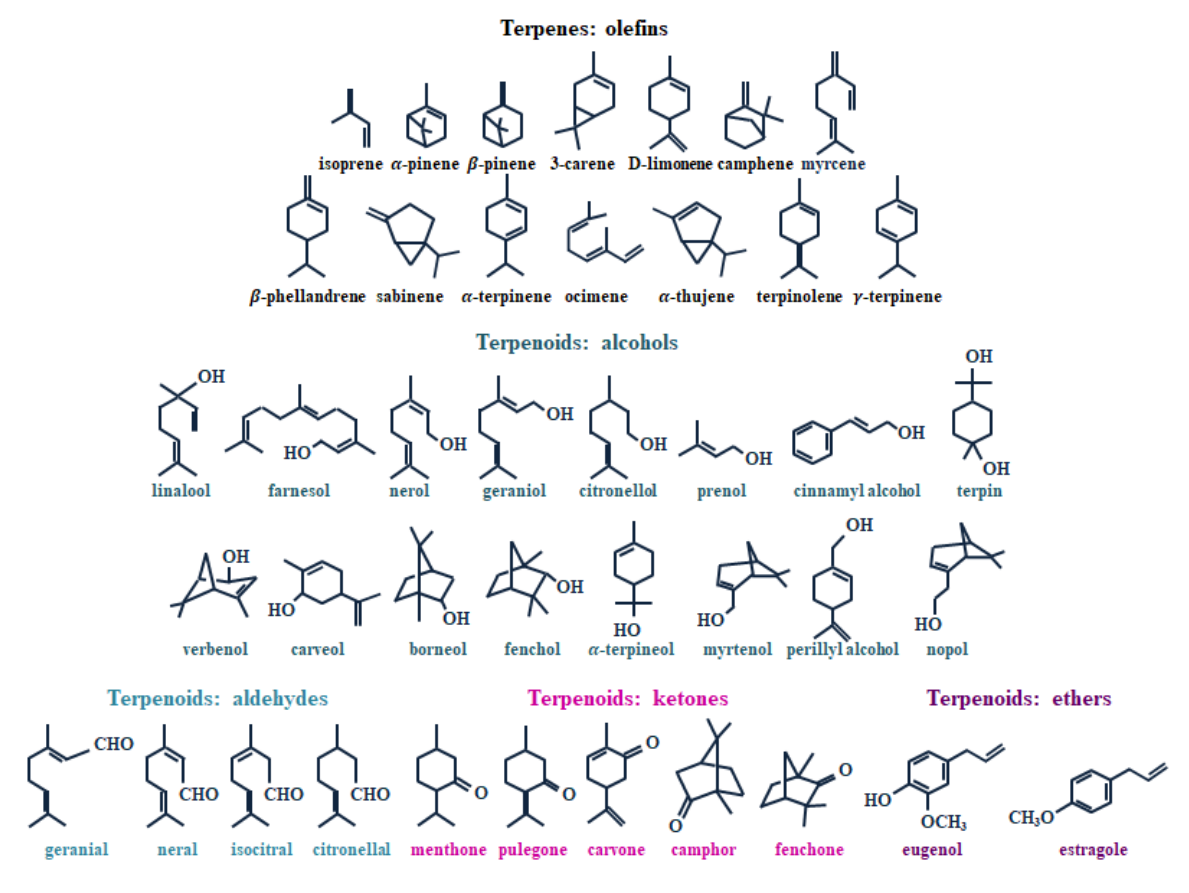
Figure 3. Main terpenes and